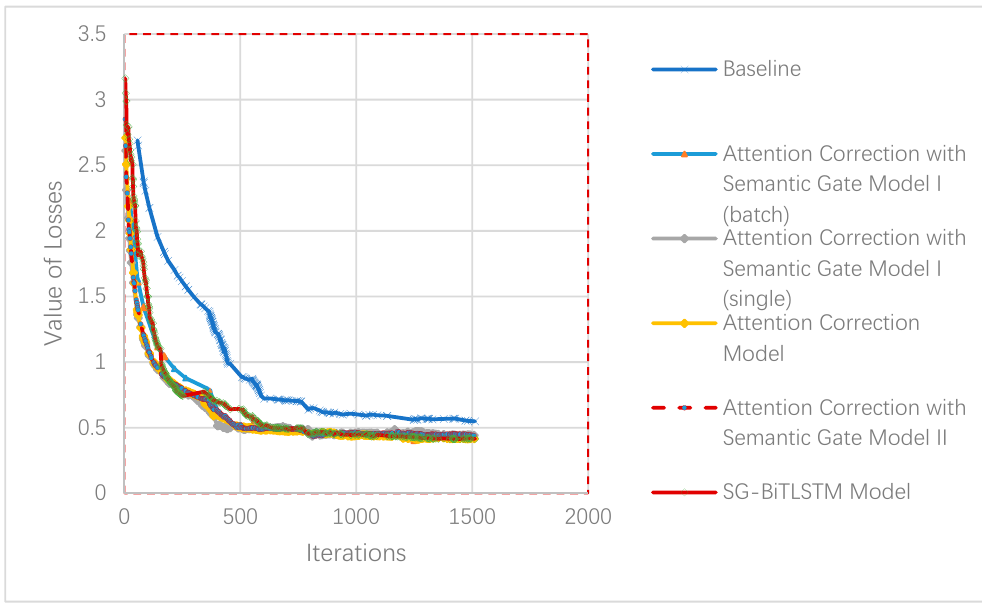
Figure 12. Losses of the Models. It shows the trends of the losses of different models.